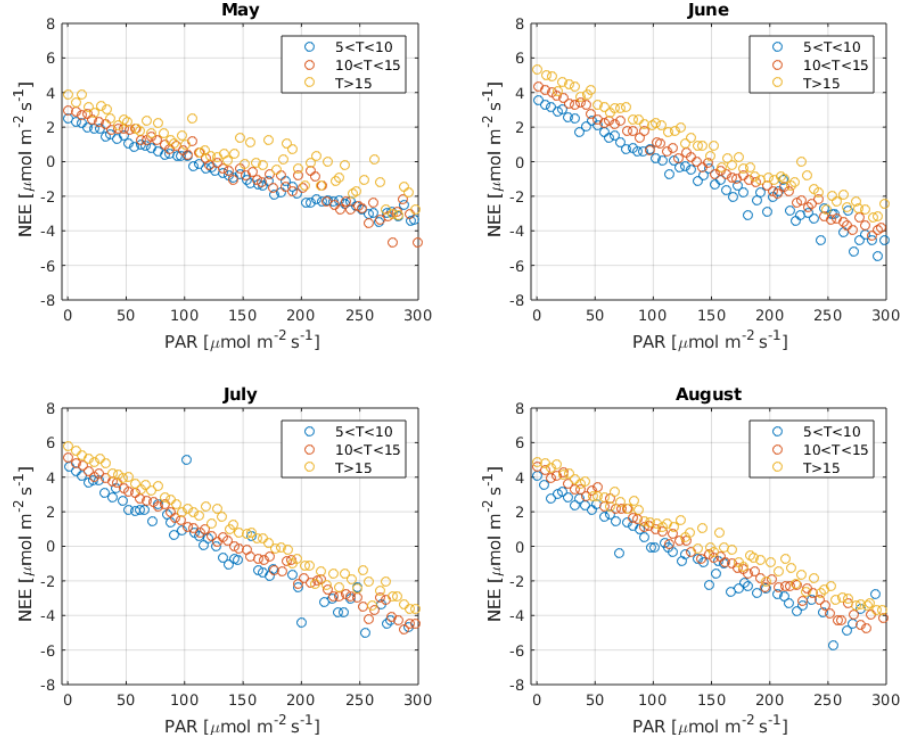
Figure B8. Net ecosystem exchange (NEE) against photosynthetically active radiation (PAR) close to the compensation point during May, June, July, and August. Data are binned to different air temperature classes: 5 ◦ C < T a < 10 ◦ C (blue), 10 ◦ C < T a < 15 ◦ C (orange), and T a > 15 ◦ C